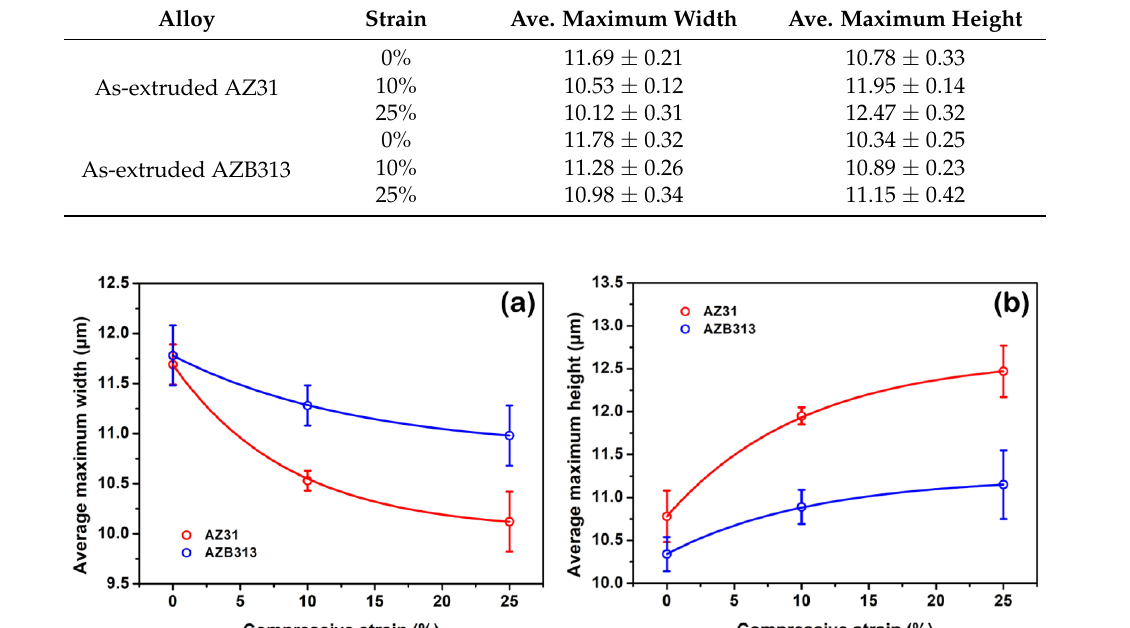
Table 2. Average maximum width (along CD) and height (perpendicular to CD) of 100 randomly selected grains from as-extruded AZ31 and AZB313 alloys after hot compressive strain of 0, 10, and 25% at 523 K. Unit: µ m.